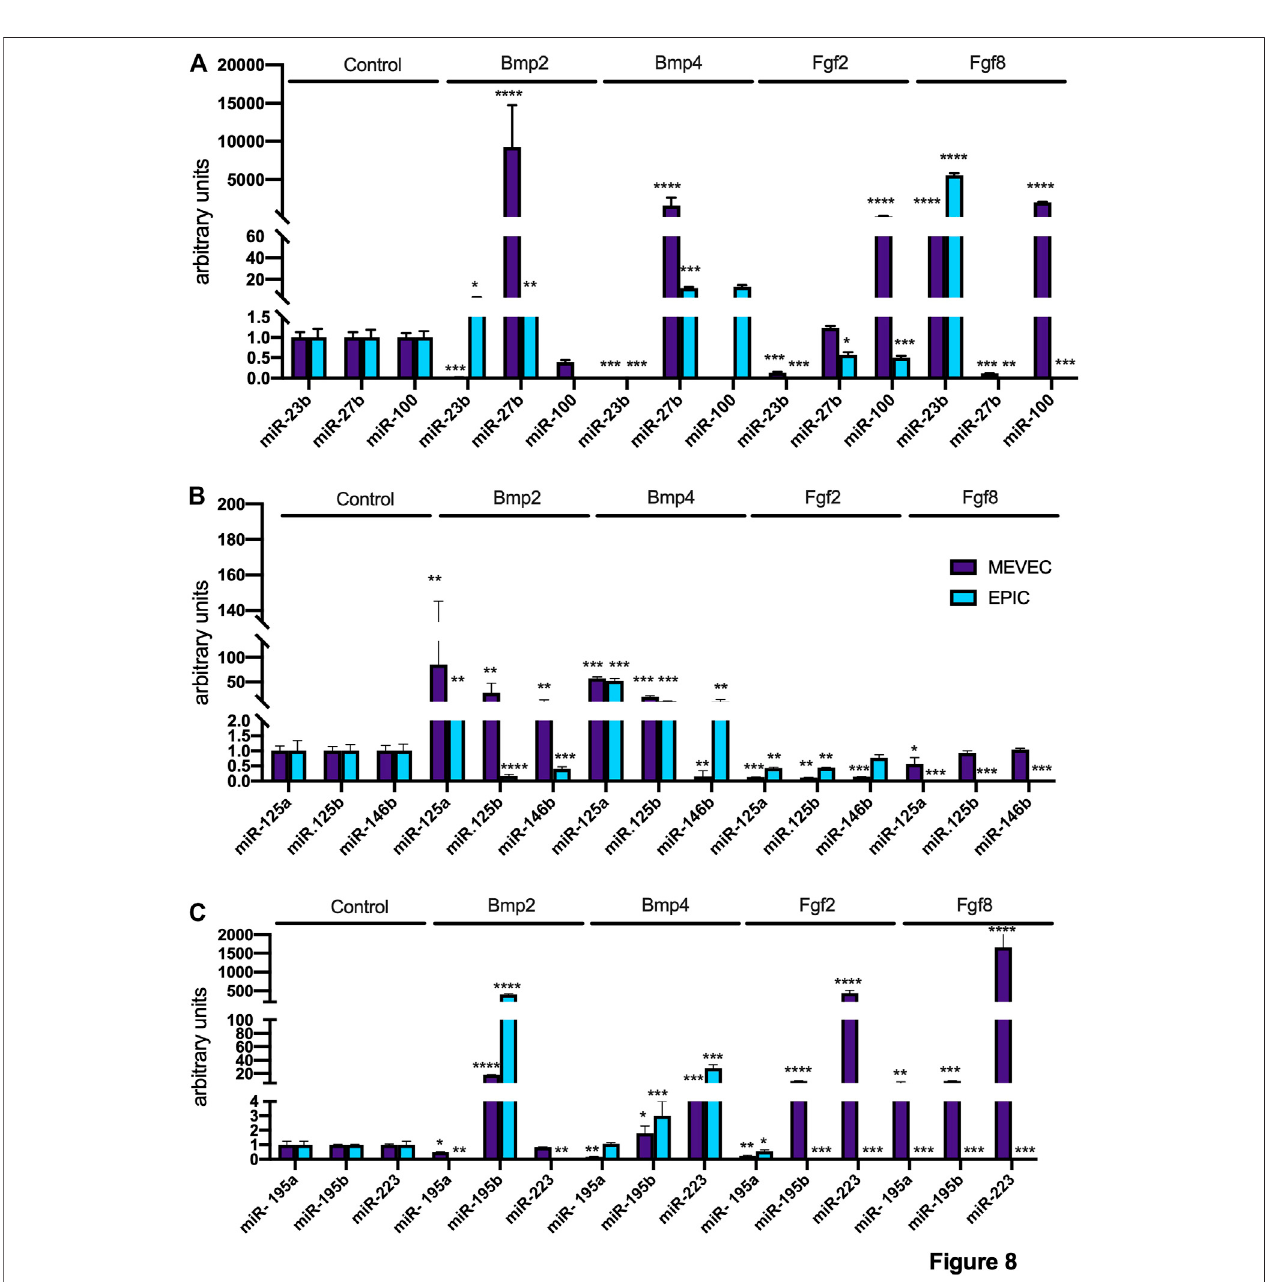
FIGURE 8 | Panel (A) RT-qPCR analyses of miR-23b, miR-27b and miR-100 expression after control, Bmp2, Bmp4, Fgf2 and Fgf8 treatments in MEVEC (endocardial) and EPIC (epicardial) cell lines, respectively. Panel (B) RT-qPCR analyses of miR-125a, miR-125b and miR-146b expression after control, Bmp2, Bmp4, Fgf2 and Fgf8 treatments in MEVEC (endocardial) and EPIC (epicardial) cell lines, respectively. Panel (C) RT-qPCR analyses of miR-195a, miR-195b and miR-223 expression after control, Bmp2, Bmp4, Fgf2 and Fgf8 treatments in MEVEC (endocardial) and EPIC (epicardial) cell lines, respectively. * p < 0.05, ** p < 0.01, *** p < 0.001, **** p <